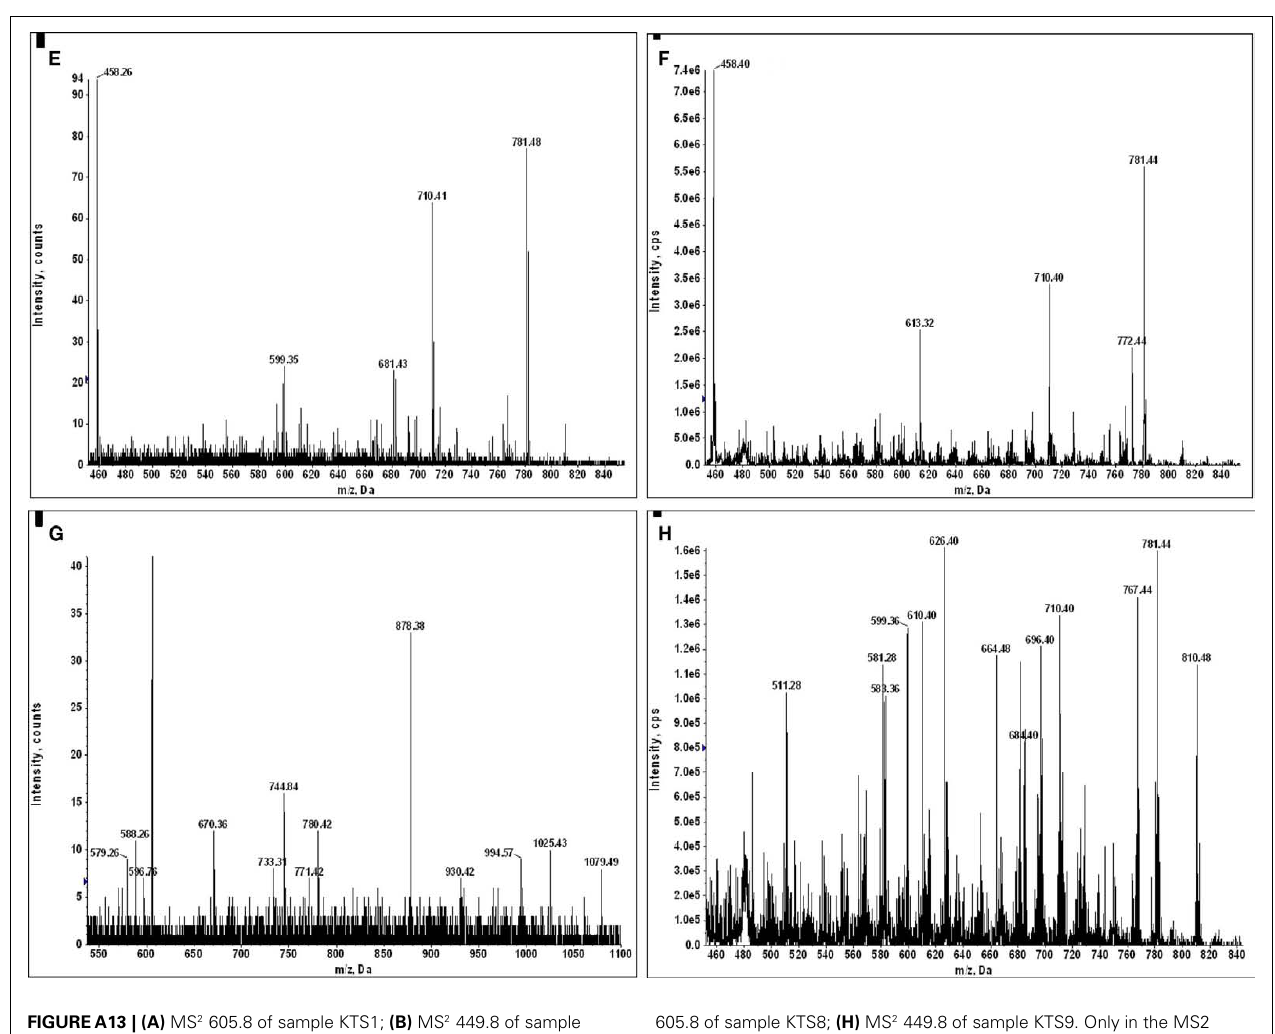
FIGUREA13 | (A) MS 2 605.8 of sample KTS1; (B) MS 2 449.8 of sample KTS2; (C) MS 2 605.8 of sample KTS4; (D) MS 2 449.8 of sample KTS5; (E) MS 2 449.8 of sample KTS6; (F) MS 2 449.8 of sample KTS7; (G) MS 2